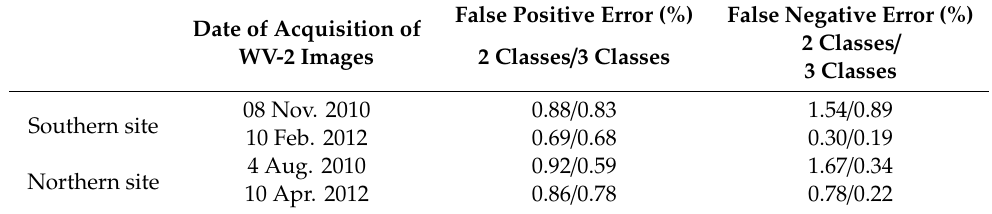
Table 1. Relative false negative and positive errors (in %) for the four WorldView-2 images.